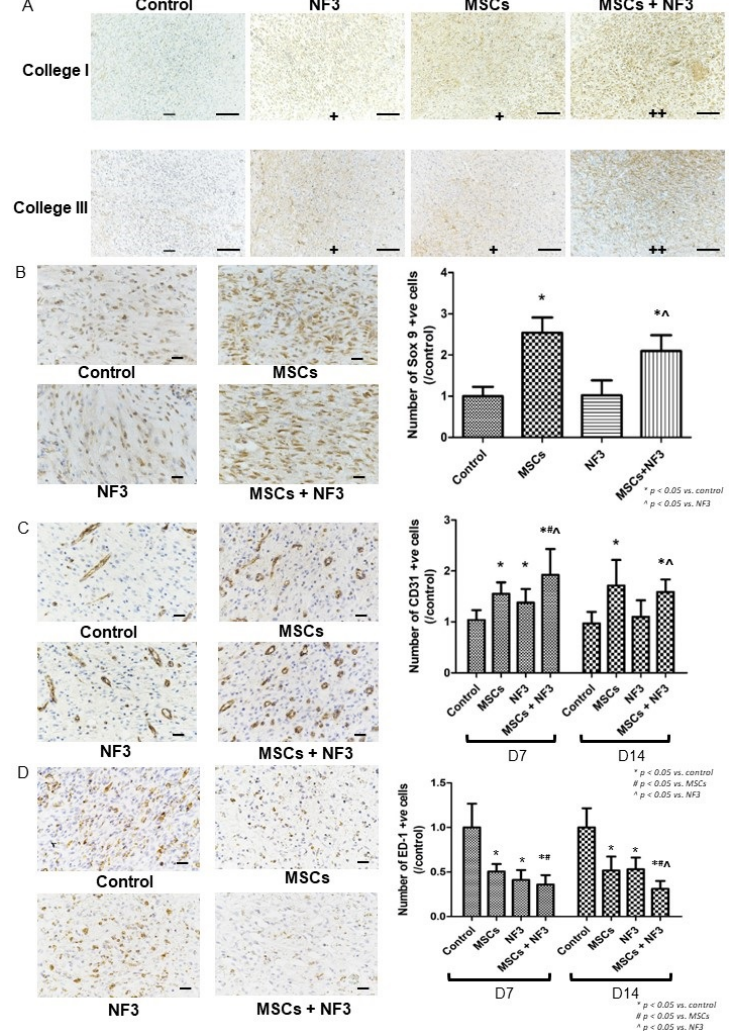
Figure 2. The representative images of IHC staining and their corresponding quantitative results. ( A ) Representative images of anti-collagen I and anti-collagen III staining (magnification: 100 × , scale bar: 100 µ m, − negative, + positive, ++ strong positive). The upper image is anti-collagen I and the lower is anti-collagen III. From left to right, the expression of the two collagens increased, and the most collagen formation was detected in the MSCs + NF3 group. ( B ) Anti-Sox 9 staining (magnification: 400 × , scale bar: 100 µ m). On the left is a representative photo of Sox 9-positive cells. Sox 9 is a marker of stem cells. We only stained the tissue collected on Day 14 to exclude the injected MSCs. The quantified data on the right indicated both MSCs and the combined treatment activated or recruited more Sox 9-positive cells ( p < 0.05). No significant difference was observed in the NF3 group. ( C ) Anti-CD31 staining (magnification: 400 × , scale bar: 100 µ m). CD31 is a marker of neovascularization. On the left are representative images of CD31 positive cells. The graph on the right indicates that both MSCs and the combined treatment increased the number of CD31 positive cells on Day 7 and Day 14, with the highest number of positive cells detected in the combined group ( p < 0.05). In the NF3 group, this increase was only observed on Day 7 ( p < 0.05). ( D ) Anti-ED1 staining (magnification: 400 × , scale bar: 100 µ m). ED-1 is a pan-marker of macrophage, which stains both activated and resting types. On the left are representative images of ED-1 positive cells. The graph on the right shows that all treatments reduced the number of ED-1 positive cells significantly on both Day 7 and Day 14, while the combined treatment further enhanced this effect ( p <